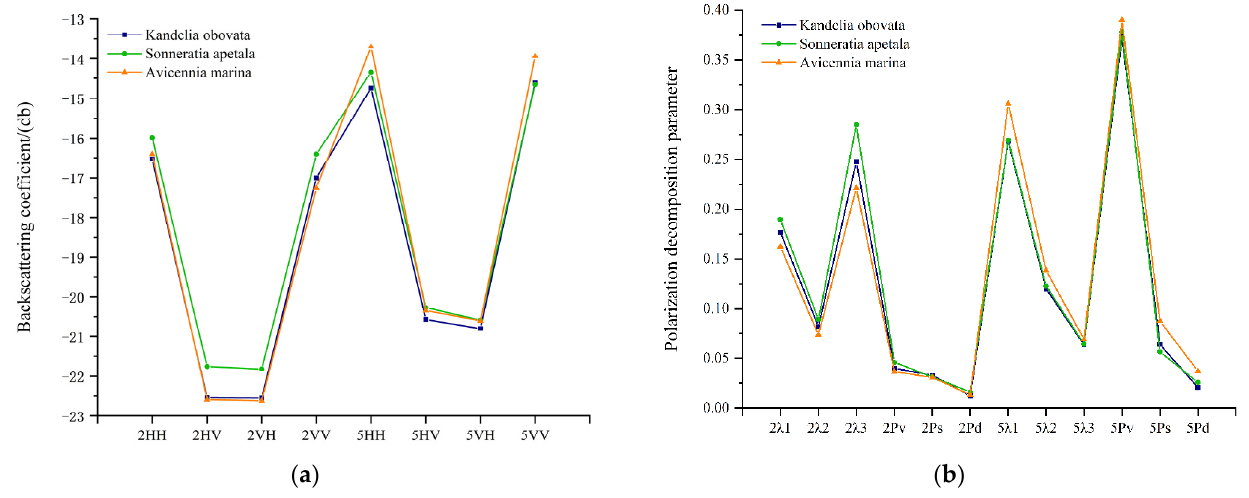
Figure 7. ( a ) Backscattering coefficients of different species in February and May; ( b ) polarization decomposition characteristics of different species in February and May.